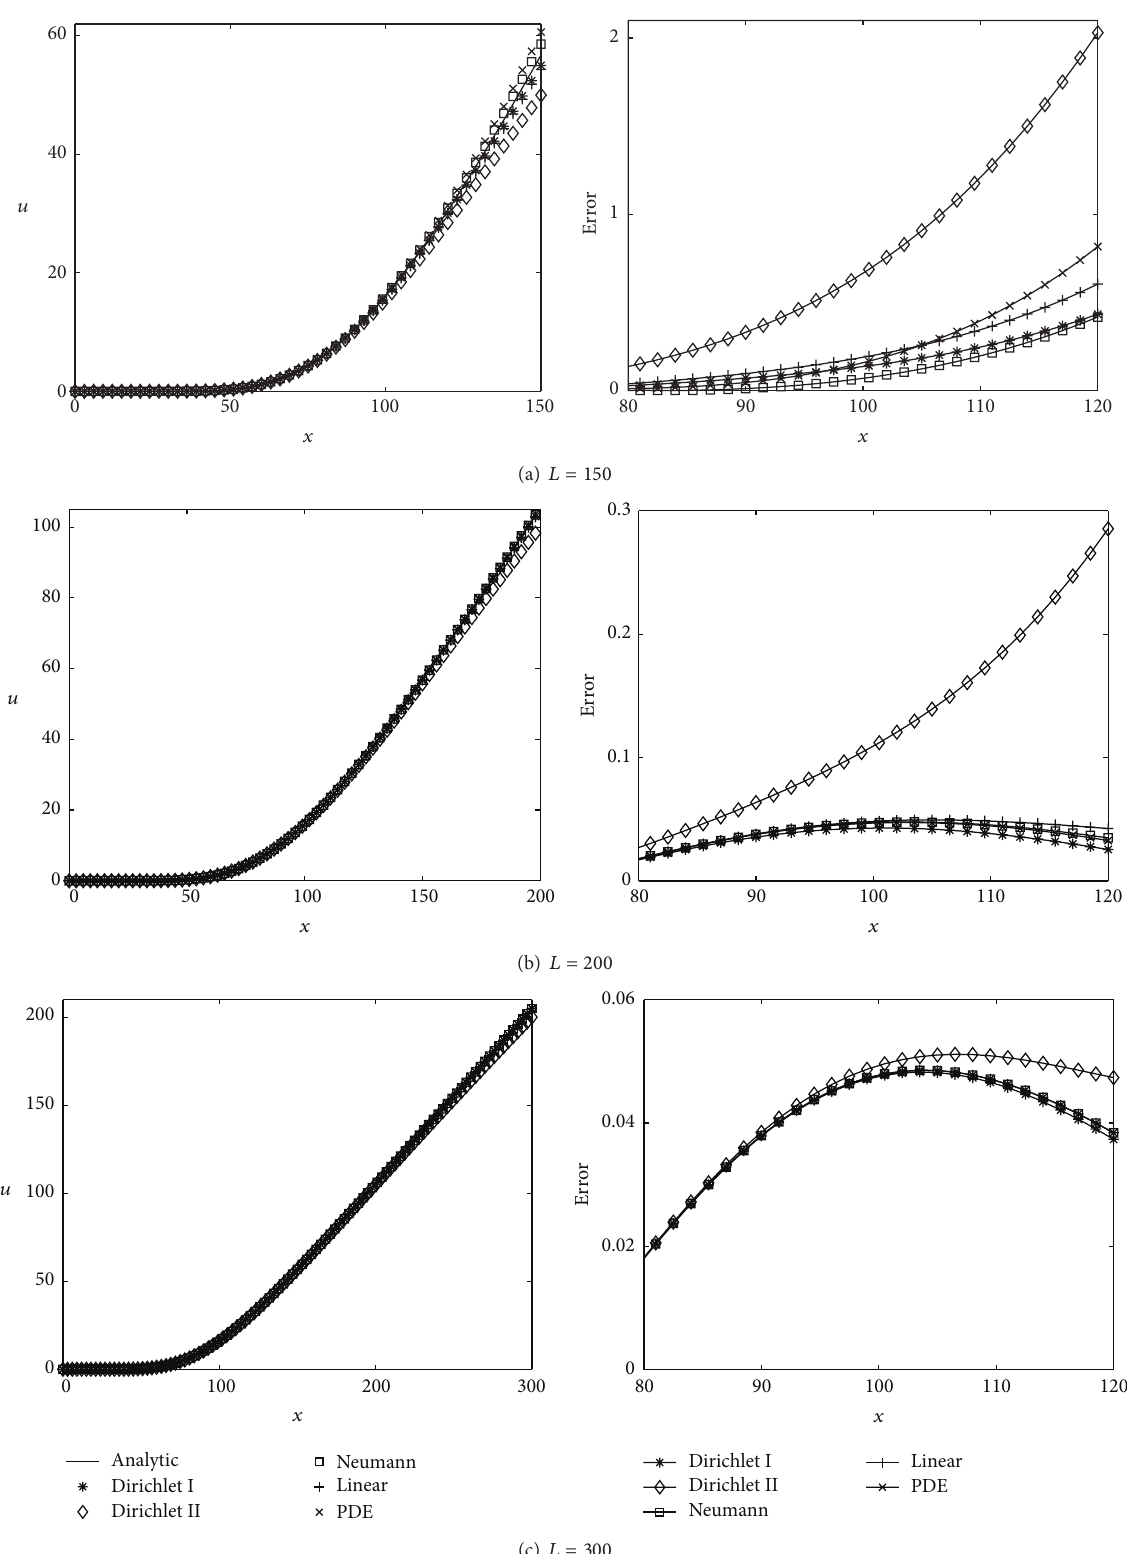
Figure 3: Comparison of European call option values (left column) and pointwise error (right column) with five BCs on different domain: (a) 𝐿 = 150 , (b) 𝐿 = 200 , and (c) 𝐿 = 300 ,